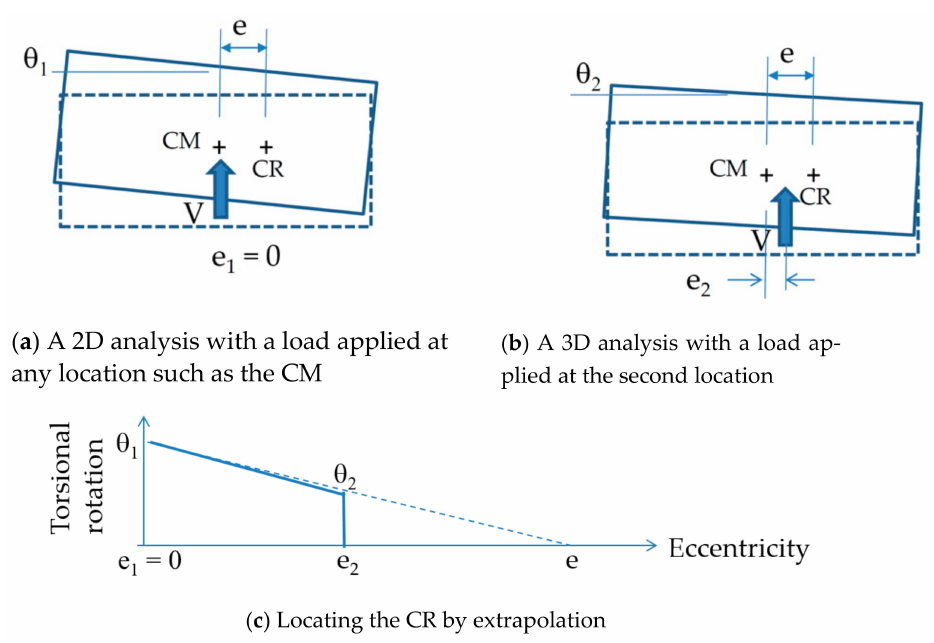
Figure 4. Method 2 of locating the CR based on 3D analyses and extrapolation.